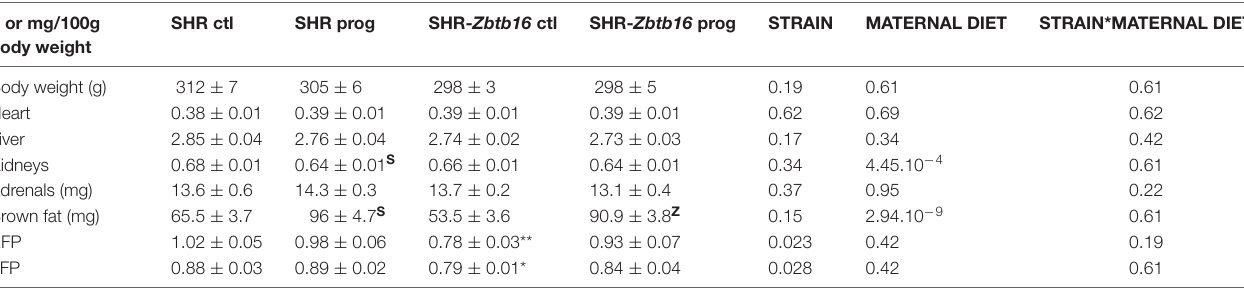
Morphometric profiles of adult SHR and SHR-Zbtb16 male rats. Values are shown as mean ± SEM (g or mg, where indicated) for organ weights per 100 g of body weight. The last three columns show significance levels of STRAIN, MATERNAL DIET major factors, and their interaction within the two-way ANOVA. RFP, retroperitoneal fat pad; EFP, epididymal fat pad. The significance levels of pair-wise comparisons by post-hoc Fisher’s least significant difference test are indicated as follows: *p < 0.05, **p < 0.01, for comparison of SHR and SHR-Zbtb16 on the same diet; S indicates the difference between control and programmed SHR (kidneys p = 0.003; brown fat p = 6.17.10 − 5 ); Z indicates the difference between control and programmed SHR-Zbtb16 (brown fat p = 1.42.10 − 6 ).